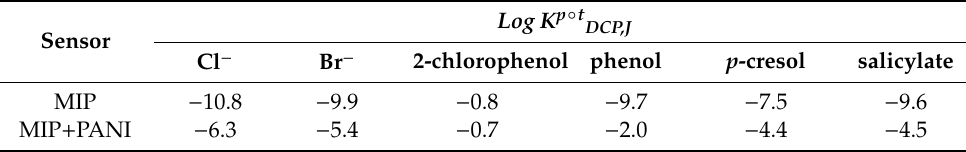
Figure 7. Potentiometric selectivity of MIP membrane-based sensors ( A ) with and ( B ) without polyaniline(PANI) as a solid-contact layer. Table 1. Selectivity coefficients, Log K p ° tDCP,J , of the proposed screen-printed sensors.